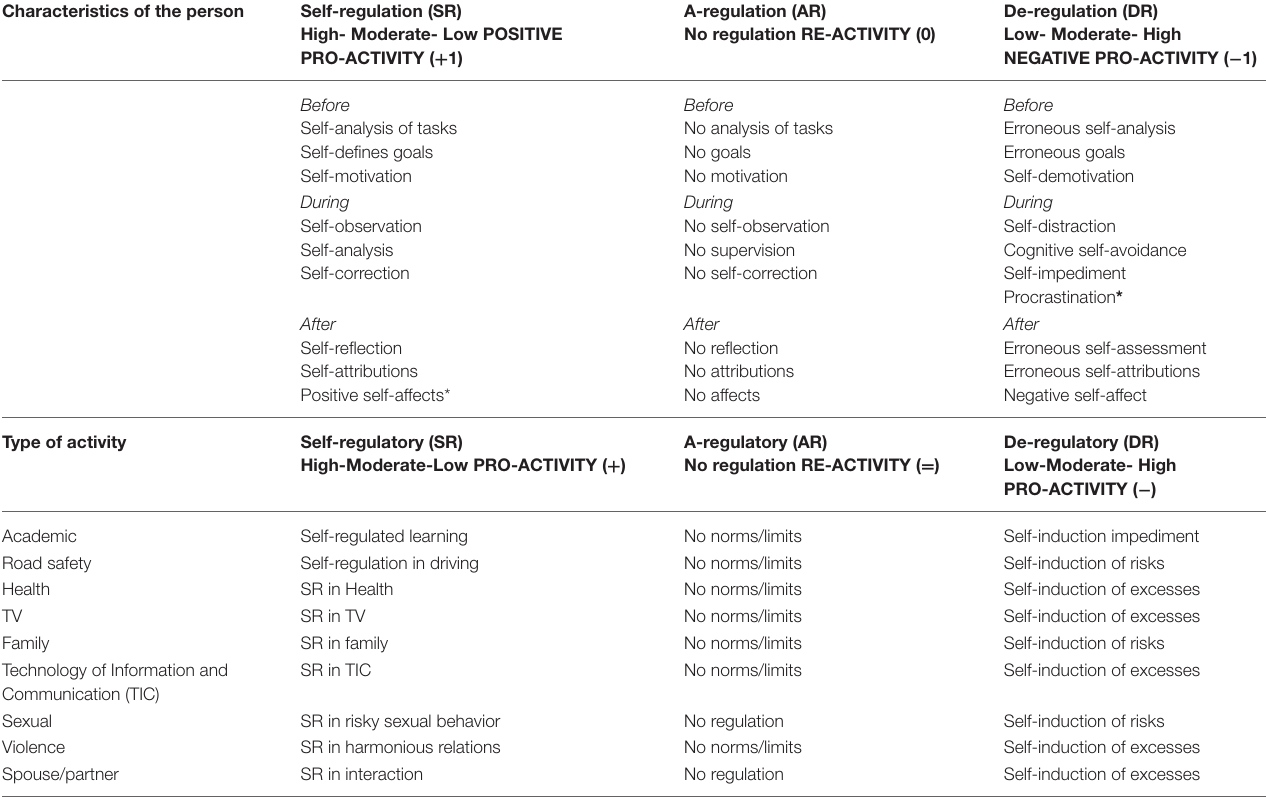
TABLE 1 | Conceptual continuum and typologies of each self-regulatory behavior (reproduced with permission). Characteristics of the